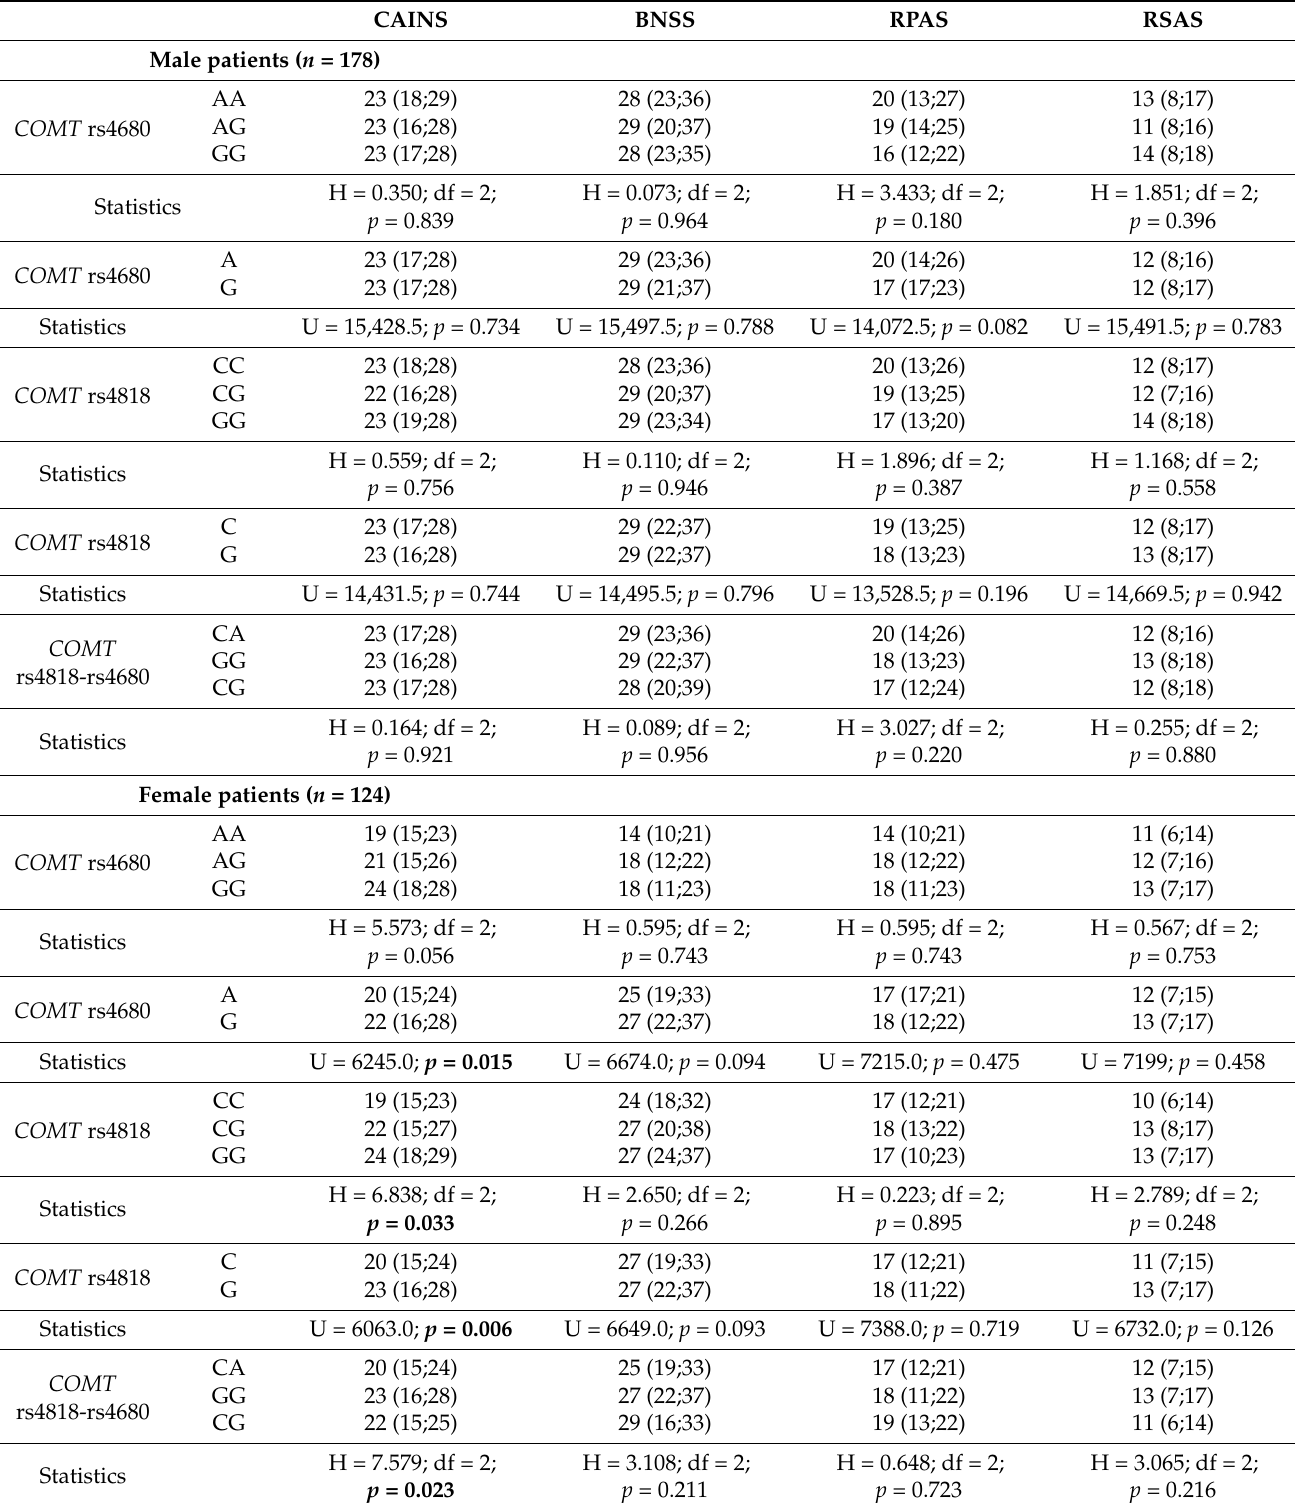
Table 3. Depressive symptoms, negative symptoms, and physical and social anhedonia depending on COMT rs4680 and COMT rs4818 polymorphisms, and their haplotypes, in male and female patients with schizophrenia. The data are denoted as median and interquartile range, while p values in bold represent statistical significance. CAINS BNSS RPAS RSAS Male patients ( n =